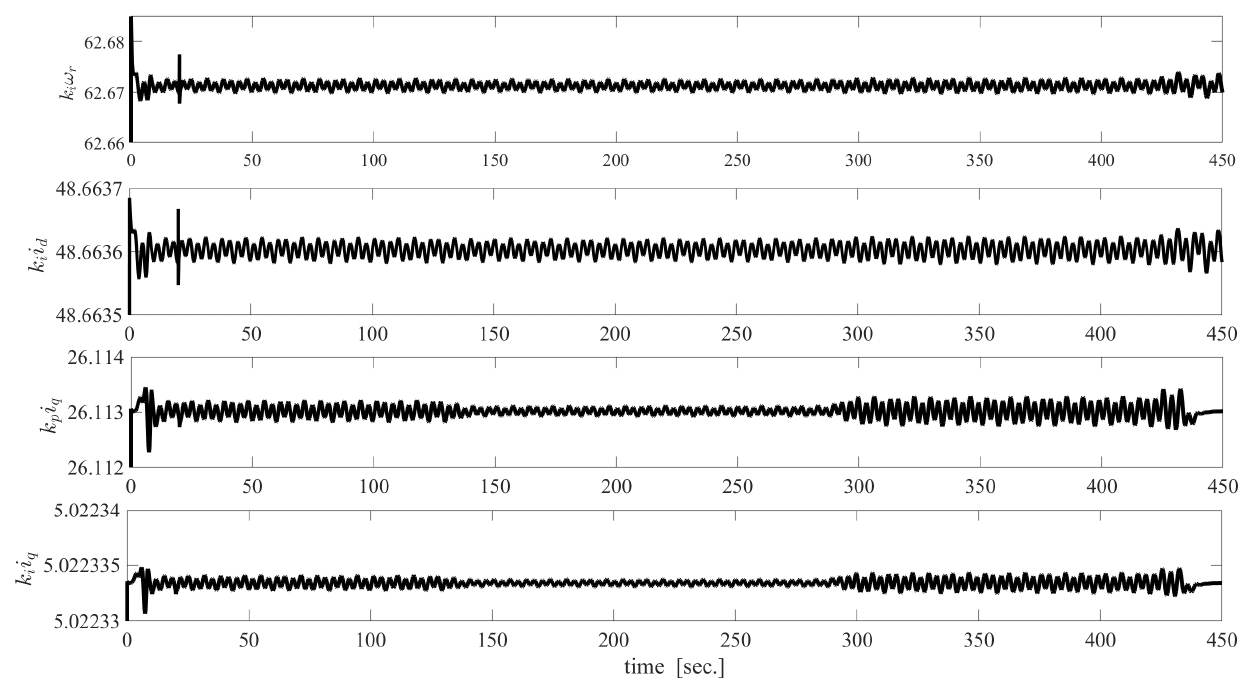
changes of load torque disturbance; ( a ) Opt.-feed; ( b ) PI-Op; and ( c ) PIBSNN.